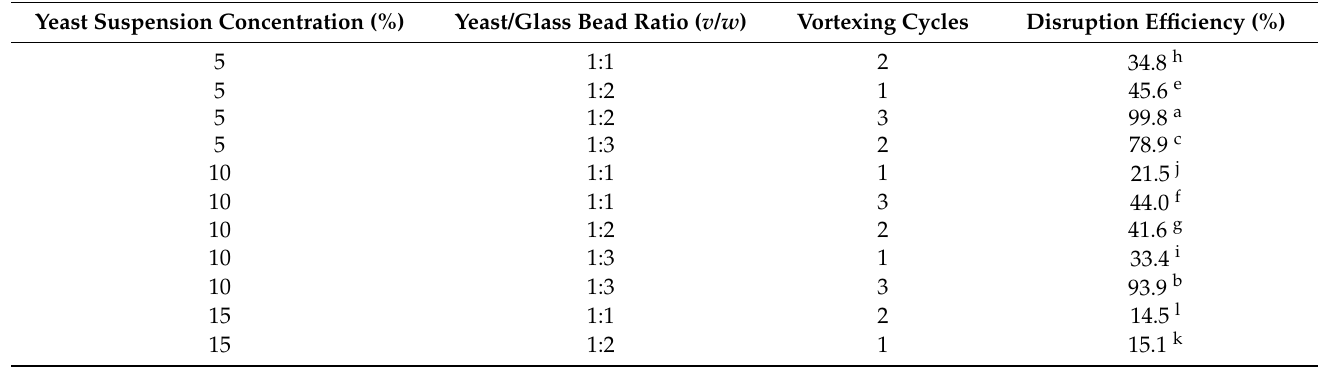
Table 2. Effects of method parameters on spent brewer’s yeast cell disruption